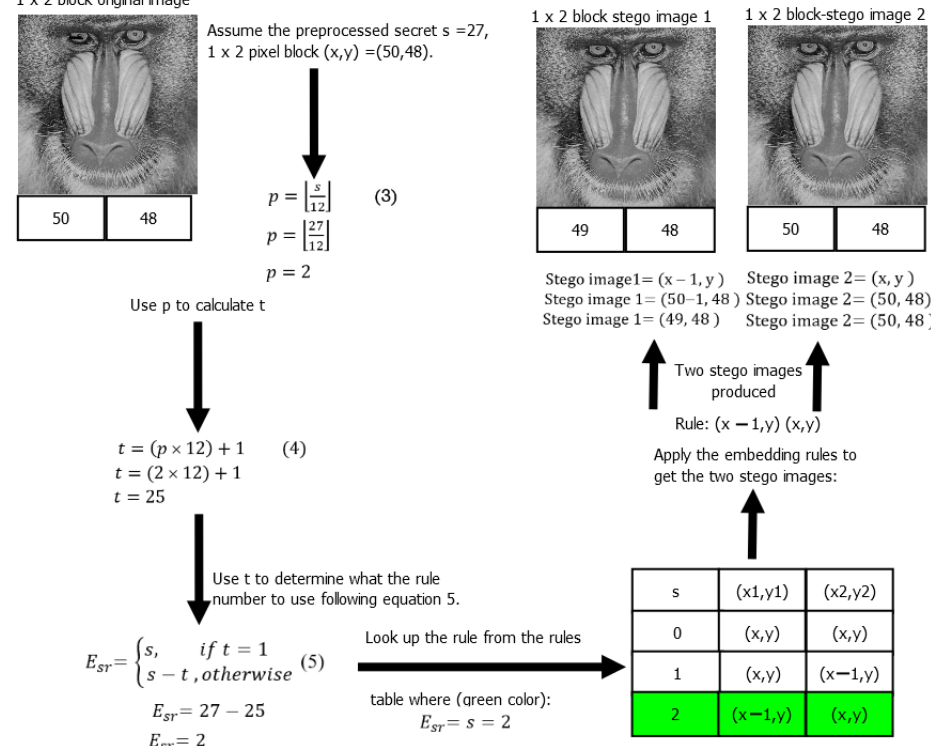
Figure 3. Embedding example of the proposed method.